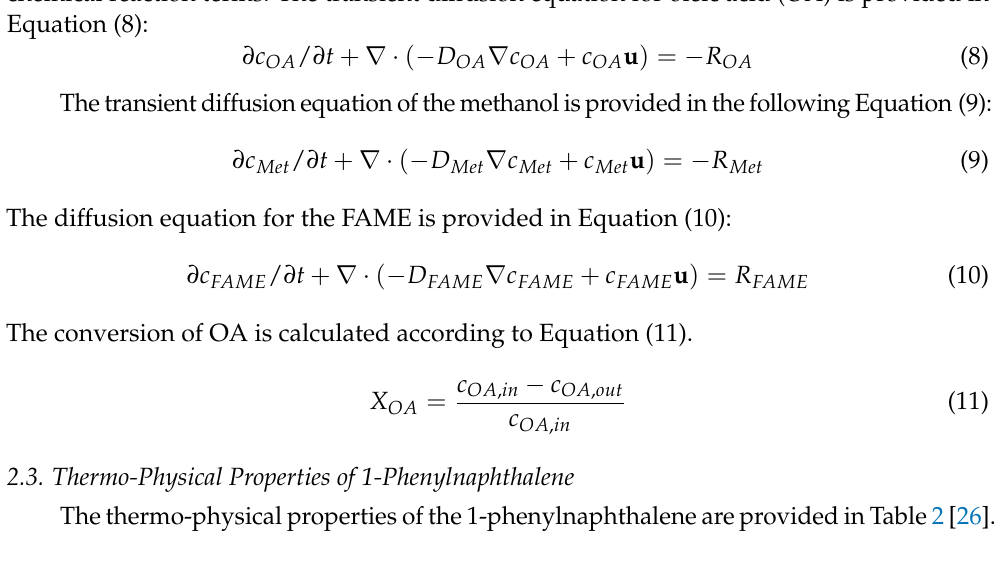
Table 2. Thermo-physical properties of 1-phenylnaphthalene (Data from Ref. [26]). Material